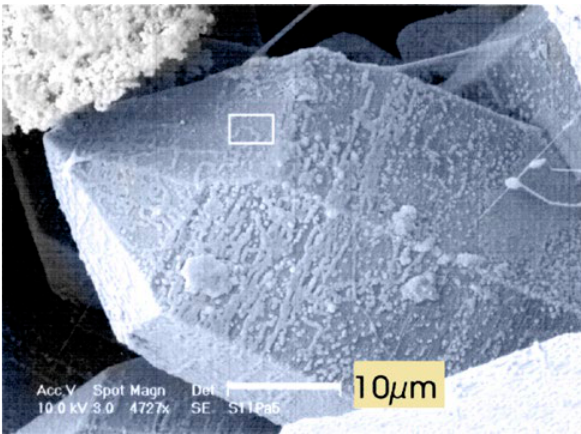
Figure 24. This euhedral crystal of clear glassy quartz was for- med in a cavity in the Waitara Sinter, Coramandel Peninsula, New Zealand. It is coated with “little balls” (about 70 to 80 nm) of amorphous polymeric silica. The silica globules are irregular in size but they tend to be arranged in ‘chains’ or lines along the crystal striations and they form a crude linear pattern on the crystal sur- face in accord with the atomic geometry of the crystal lattice (from Newton 12 ,